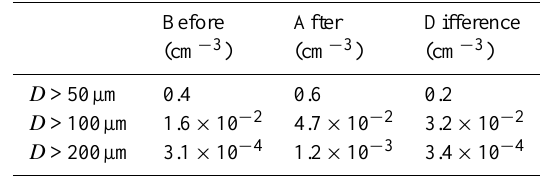
Table 4. Total droplet number concentrations larger than critical sizes. Numbers are average concentrations at three cloud levels.